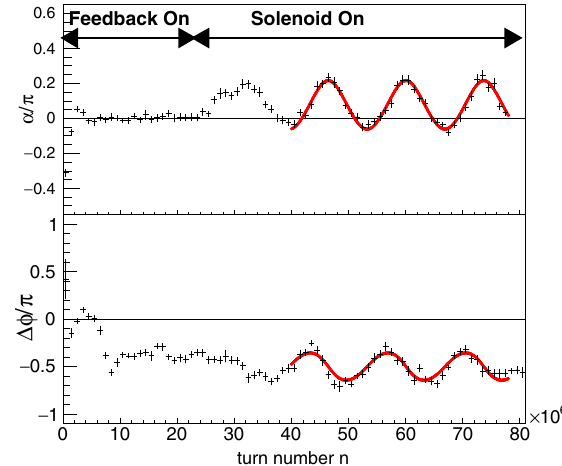
FIG. 5. Observation of bound oscillation of Δ ϕ around − π = 2 . The fit results correspond to k ¼ ð 8 . 95 (cid:2) 0 . 11 Þ × 10 − 7 , q ¼ 0 . 250 (cid:2) 0 . 027 and C ¼ − 0 . 934 (cid:2) 0 . 013 at a χ 2 = NDF of 101 . 4 = 74 0 .